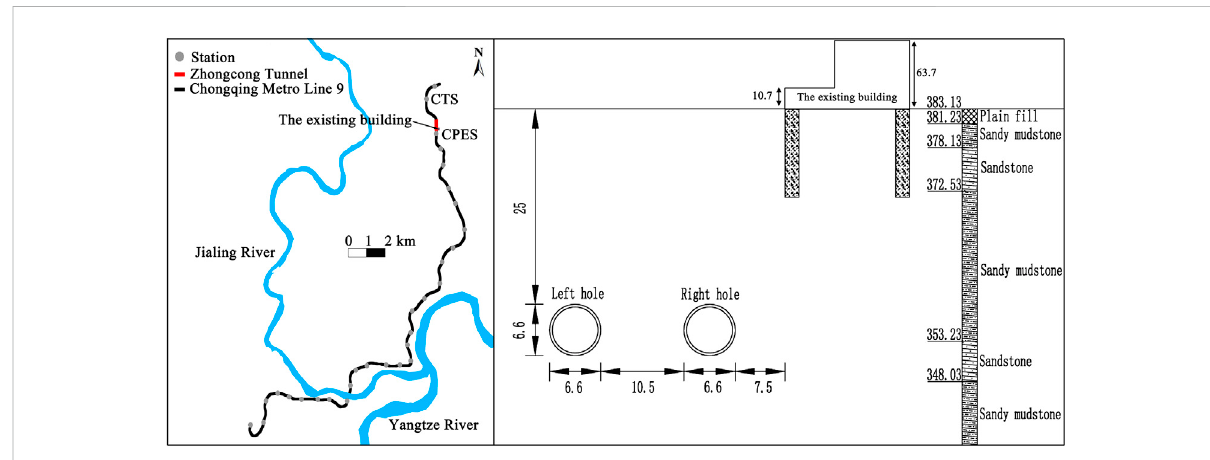
FIGURE 1 Location of the Zhongcong Tunnel in Chongqing Metro Line 9, and the pro fi le map of the underpass existing building.